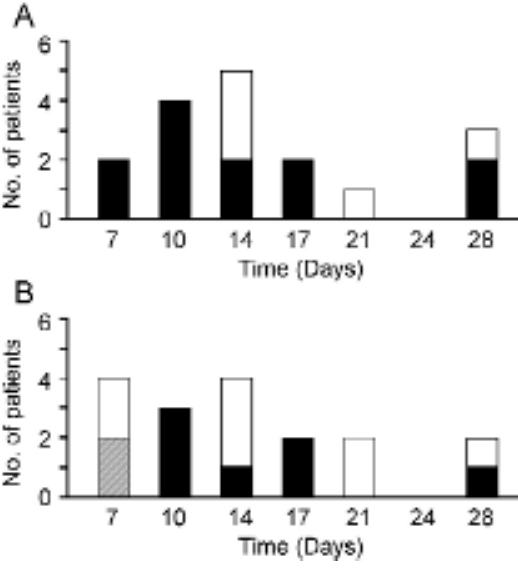
Figure 1 Time to positive spirometric and/or exercise responses dur- ing an oral corticosteroid trial. Black bars represent spirometric responders, white bars de- pict exercise responders, grey bars show subjects who were both spirometric and exercise responders at the same time- point. The number of subjects is shown. Total n = 30. A. Time-points at which subjects meet spirometric response criteria for the first time (increase in post-bronchodilator FEV 1 0 15% and 0 200 ml from baseline). In addition, 5 exer- cise responders are shown (increase in 6MWD 0 55 m from baseline). B. Time-points at which subjects first met spiro- metric or exercise response criteria for the first time.